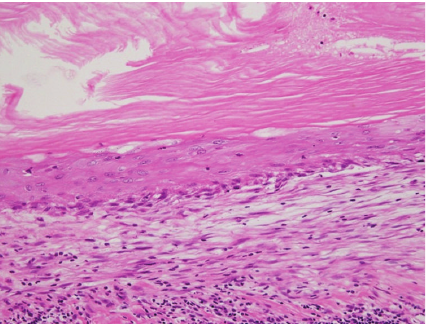
Figure 4: Histopathology of the surgical specimen (H-E × 200). The wall was lined by relatively thin keratinized stratified squamous epithelium and the lumen was filled with soybean cord-like kera- tinized